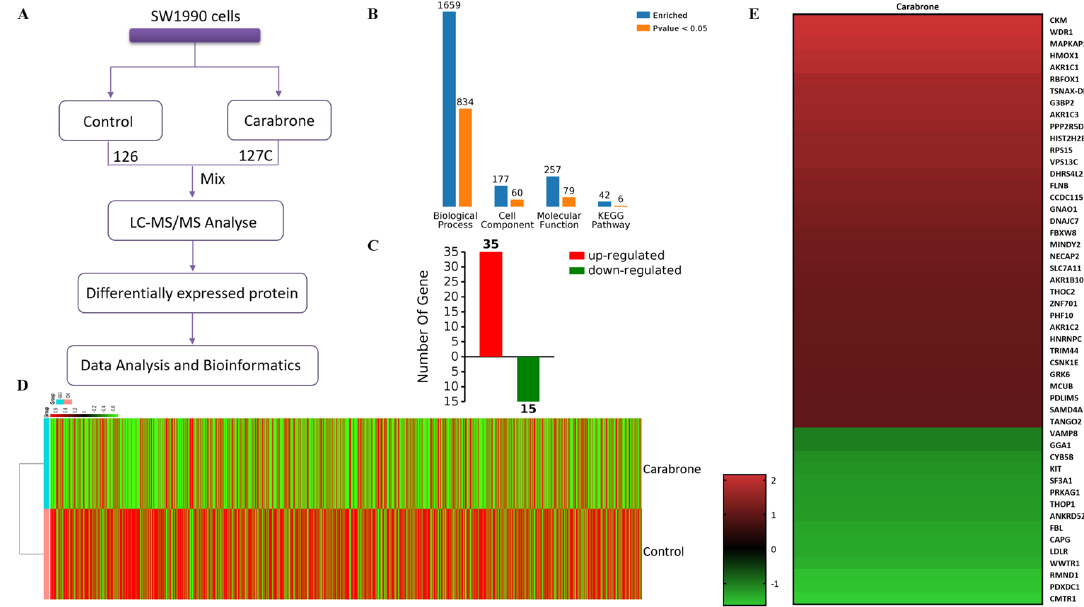
Figure 3. TMT-based proteomics analysis. ( A ) Flowchart for proteomics analysis. Proteins in carabrone-treated SW1990 cells were labeled with 126 and 127C TMT labels. Labeled samples were an- alyzed by LC-MS/MS and differentially expressed proteins were analyzed by database searching. ( B ) The differentially expressed proteins were enriched and analyzed. ( C ) Number of differentially expressed proteins. ( D ) Heatmap of the expression levels of 9864 total proteins. The red-colored